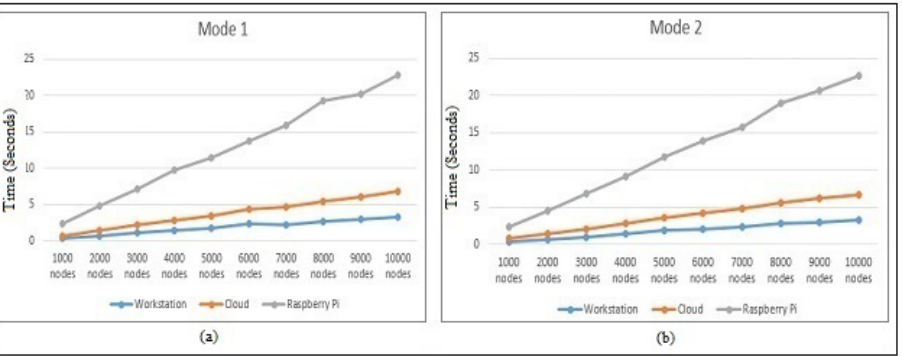
Figure 8. Performance with respect to the hash-chain fog/edge protocol in ( a ) Mode 1 and ( b ) Mode 2 time on the workstation, AWS Cloud, and Raspberry Pi.